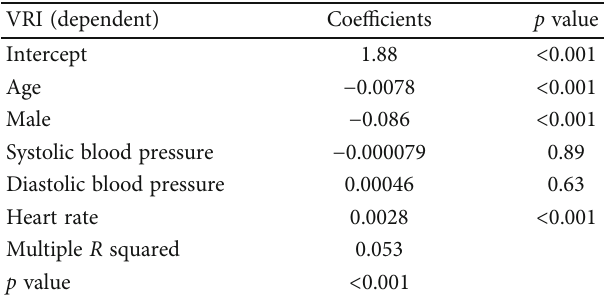
Figure 5: Associations between vascular reactivity index (VRI) and age in Registry-I (a) and in Registry-II (b). Table 2: Linear regression model showing associations with vascular reactivity index